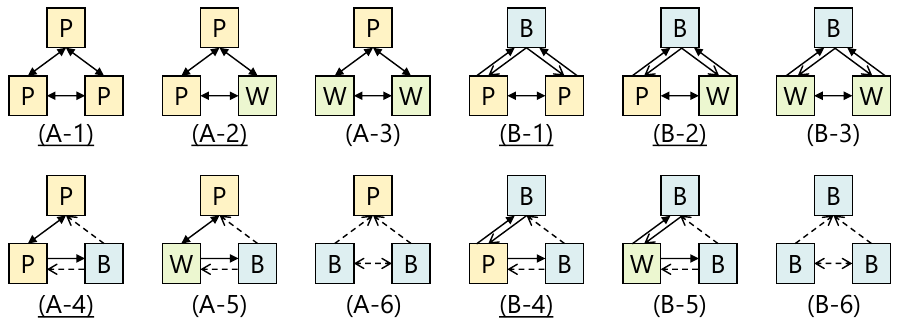
Figure 1. Results of preliminary experiment. The top upper box of each topology is the GO and the two lower boxes are CL s. The solid arrows represent unicast communication is available, the dotted arrows represent broadcast communication is available, and the filled solid arrows represent both communications are